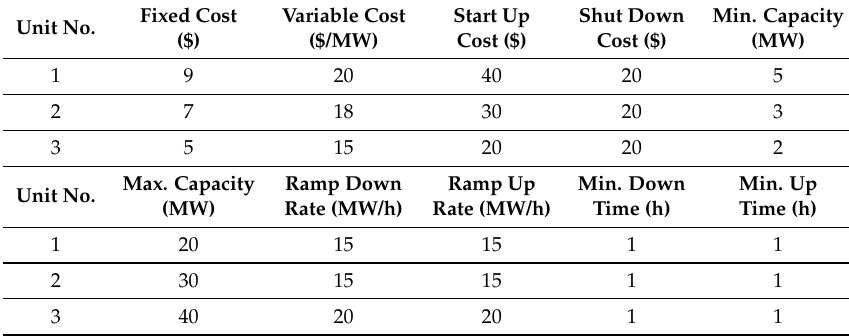
Figure 8. Wind frequency histogram and Weibull distribution for all wind speeds in Dhahran. Table 3. Characteristics of generation